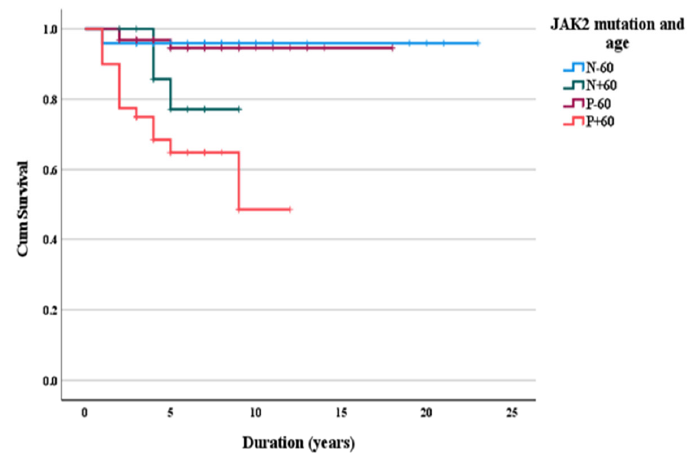
Figure 1. Long ‐ term survival according to age and JAK2V617F status. Figure 1. Long-term survival according to age and JAK2V617F